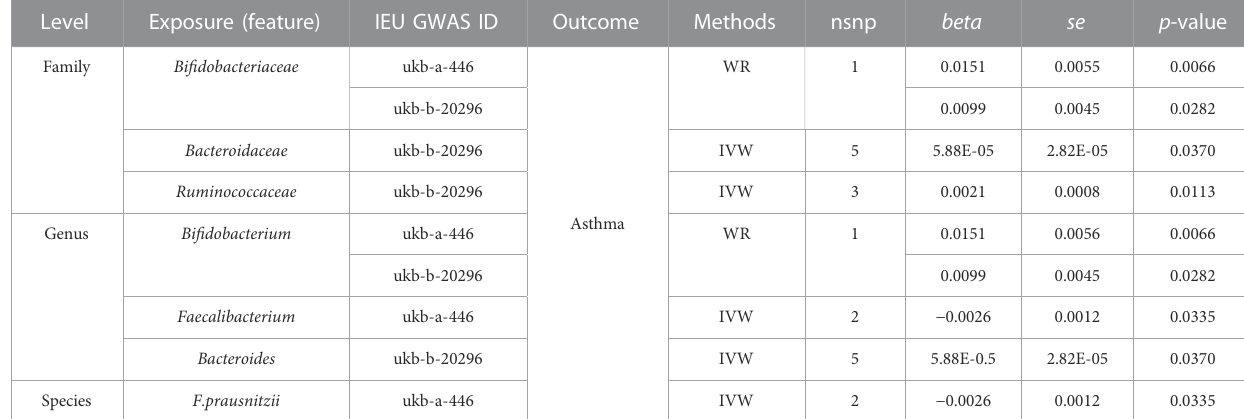
TABLE 3 Signi fi cant 2SMR analysis results between gut microbiome composition and asthma.